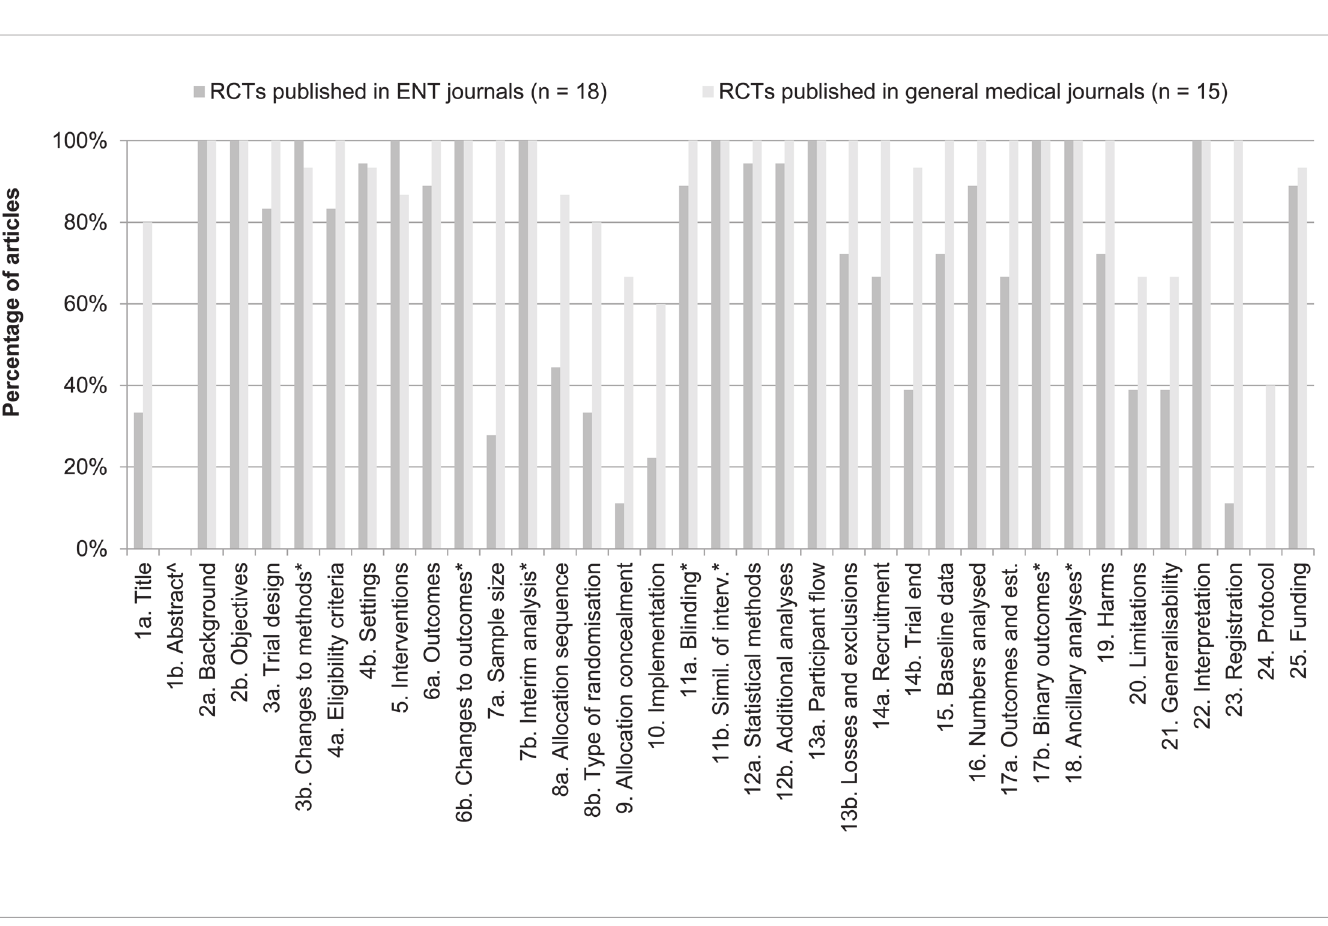
Fig 2. Reporting of CONSORT items per journal type. The percentage of articles reporting CONSORT items adequately (in %), sorted per journal type (articles published in general medical journals, n = 15; articles published in ENT journals, n = 18), using the CONSORT 2010 checklist [10]. ^ Item 1b: item Structured summary is assessed with the specific CONSORT for Abstracts checklist [12], see Fig. 3. * Marked items concern optional items. When possible in the study and adequately reported, the item was scored as ‘ adequately reported ’ . When possible, but not reported, the item was scored as ‘ inadequately reported ’ . If not possible, the item was not scored as ‘ inadequately reported ’ , but left open.